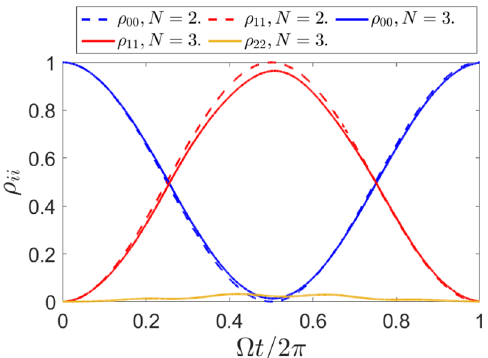
Fig. 5 Dynamics of a driven transmon. Dynamics of the diagonal elements of the density operator of a driven transmon in the rotating frame. The transmon is initially in the ground state. The parameters here are Ω = 0.01 ω 01 and ω d = ω 01 .